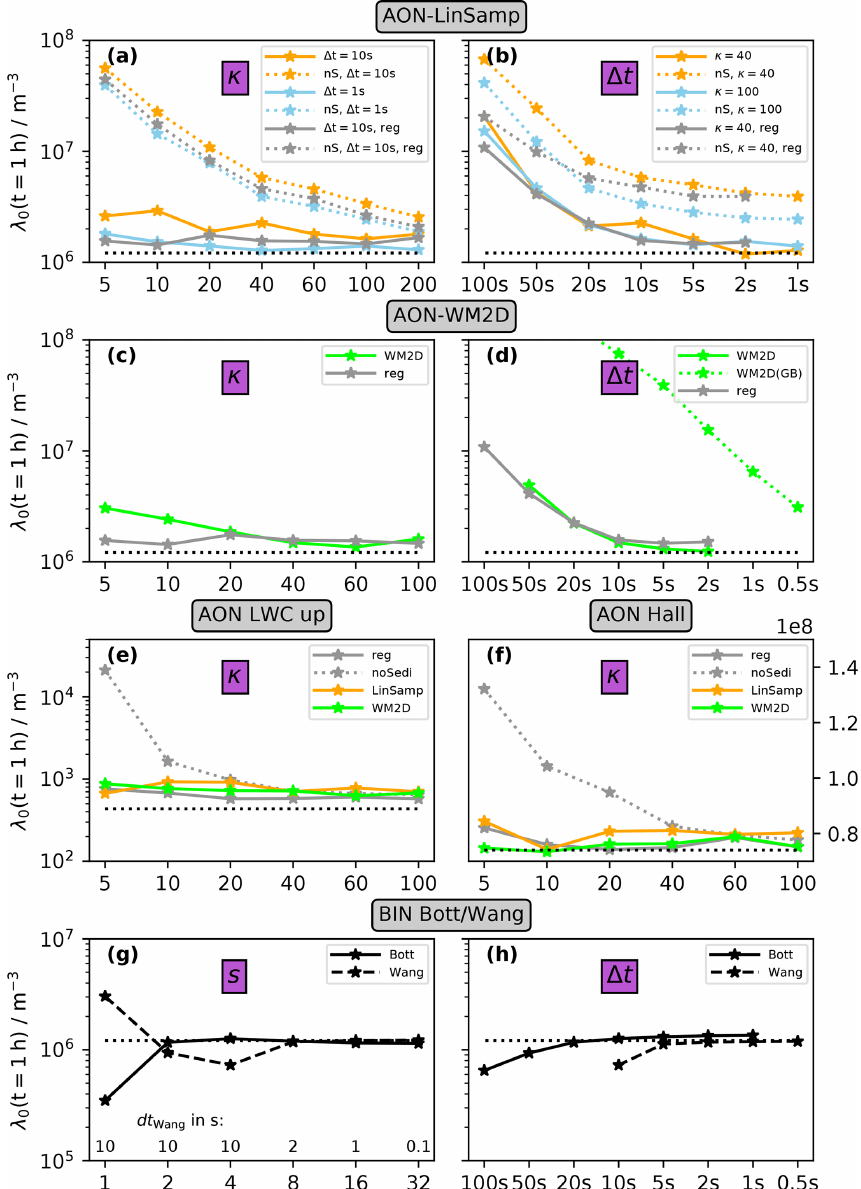
Figure 6. BoxModelEmul set-up: this figure summarises results of many sensitivity studies for various AON versions and BIN simulations by displaying DNC after 1h as a function of resolution κ (or analogously s in BIN models) or time step (cid:49)t . The default parameter settings are listed in Fig. 5 and the horizontal black dotted curve shows the BIN benchmark reference. For example, the information of Fig. 5c and d is compressed into the two grey curves in panel (a) . Panels (a) and (b) additionally show AON simulations with linear sampling (as described in Sect. 2.3.3), unless “reg” in the legend indicates regular AON with quadratic sampling. “nS” is short for “NoSedi”. The second row shows simulations with explicit overtakes and a 2D well-mixed assumption (“WM2D”, as described in Sect. 2.3.2). Again, the regular AON with WM3D serves as reference. In the simulation labelled “WM2D(GB)”, overtakes are considered only between SIPs inside the same GB, whereas “WM2D” checks overtakes in the full column. Panel (e) shows a scenario with (increased) LWC init = 1 . 5gm − 3 and (f) uses the Hall kernel instead of the Long kernel. Note that the y ranges are different in the third row. The fourth row shows BIN results with Bott’s and Wang’s algorithms. The default parameters are s = 4 and (cid:49)t =